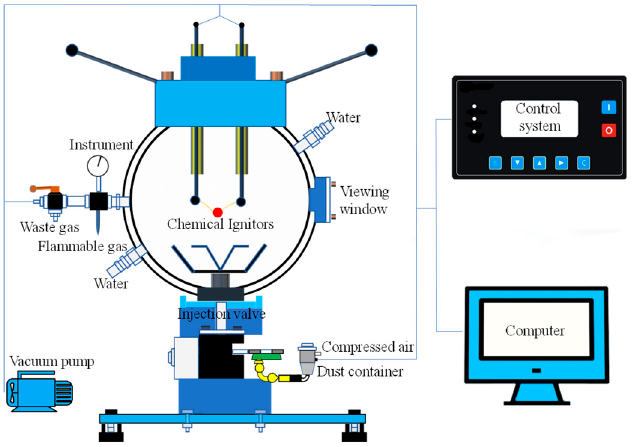
Figure 1. 20 L spherical explosive system.